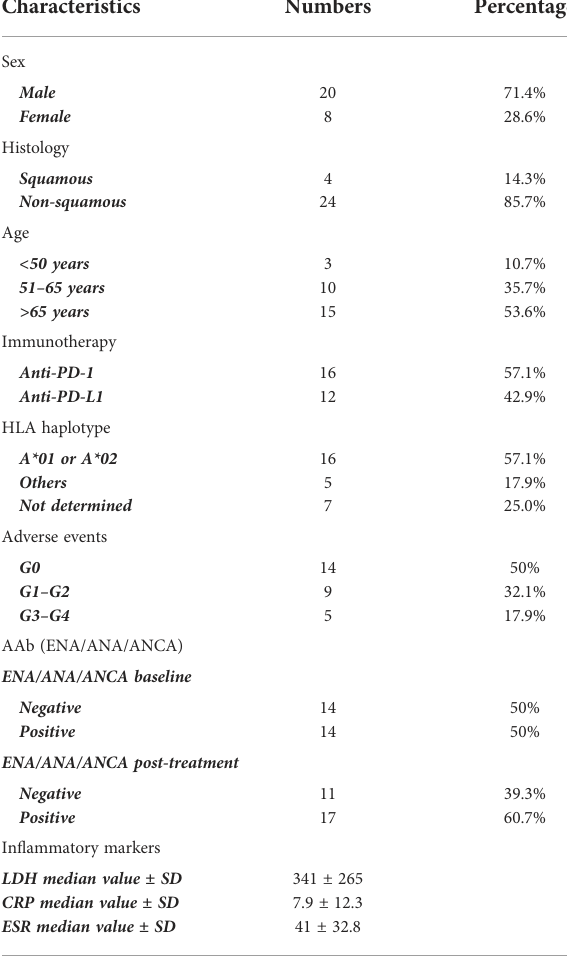
TABLE 1 Patient characteristics at